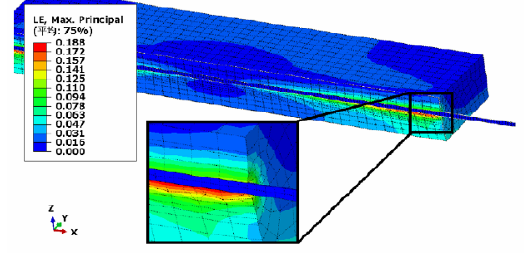
Fig. 5 Finite element model and grid division.